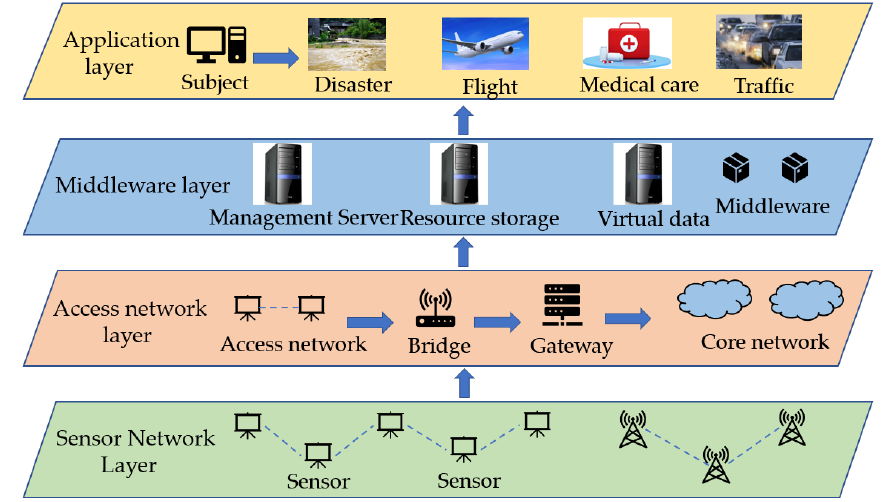
Figure 3. Positioning hierarchy of the Internet of Things based on sensor networks.